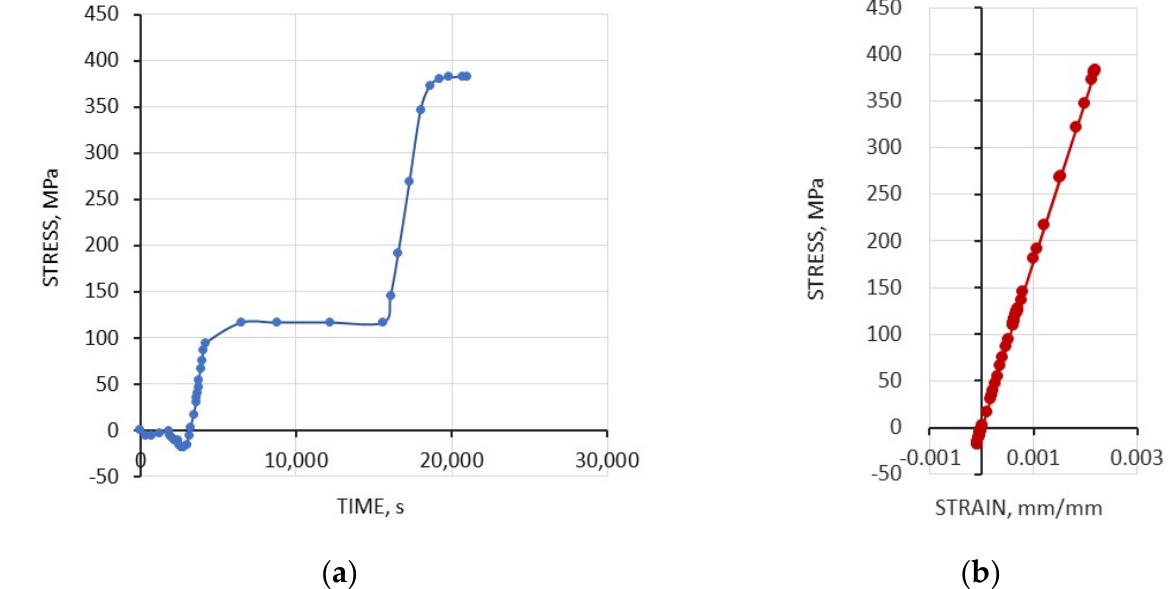
Figure 13. The ( a ) stress versus time and ( b ) stress versus strain relationships for the MC FAST cold startup computational model, with an increased rate of change of steam temperature.